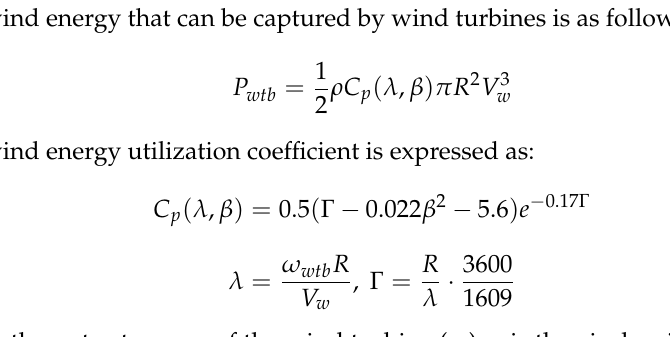
Figure 7. Power–wind speed distribution.